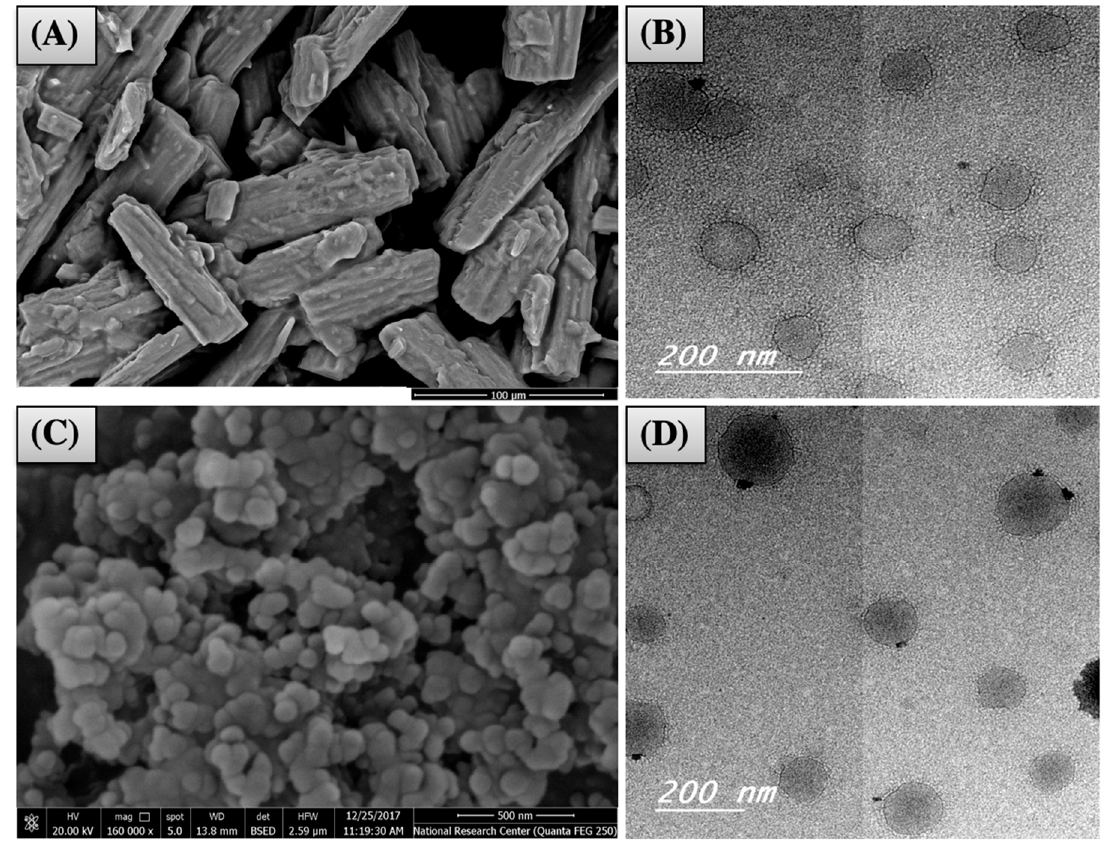
Figure 6. Imaging of OFM ( A : by SEM and B : by TEM) and OFA ( C : by SEM and D : by TEM).